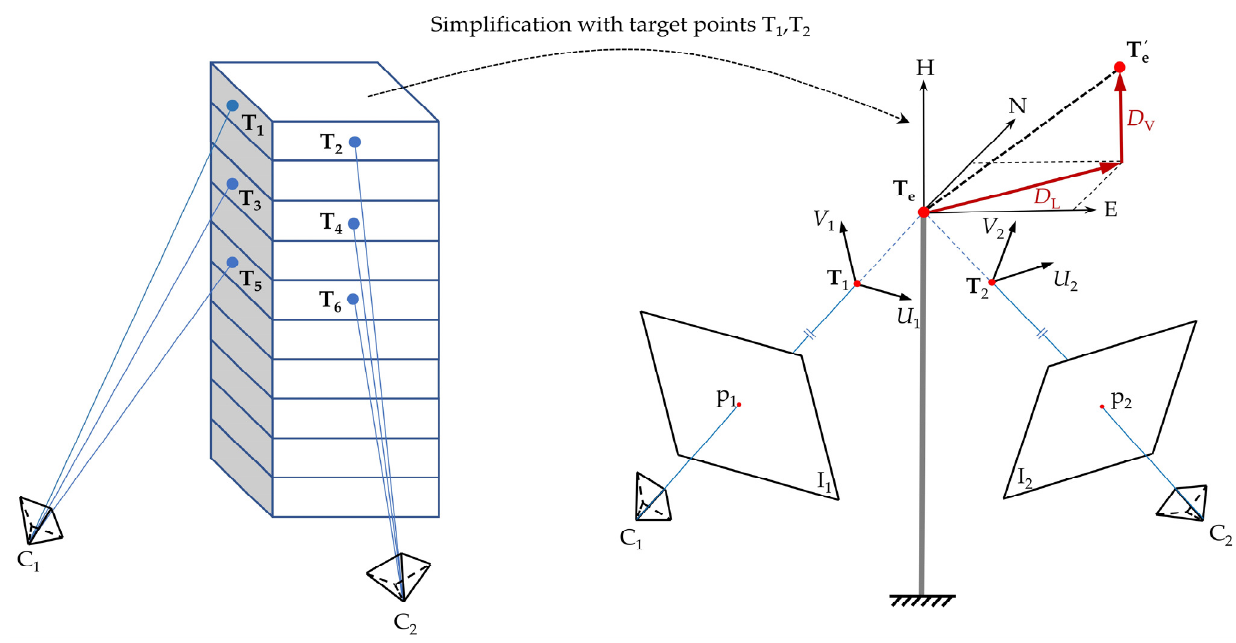
Figure 1. 3D displacement sensing with two non-overlapping cameras C 1 and C 2 .